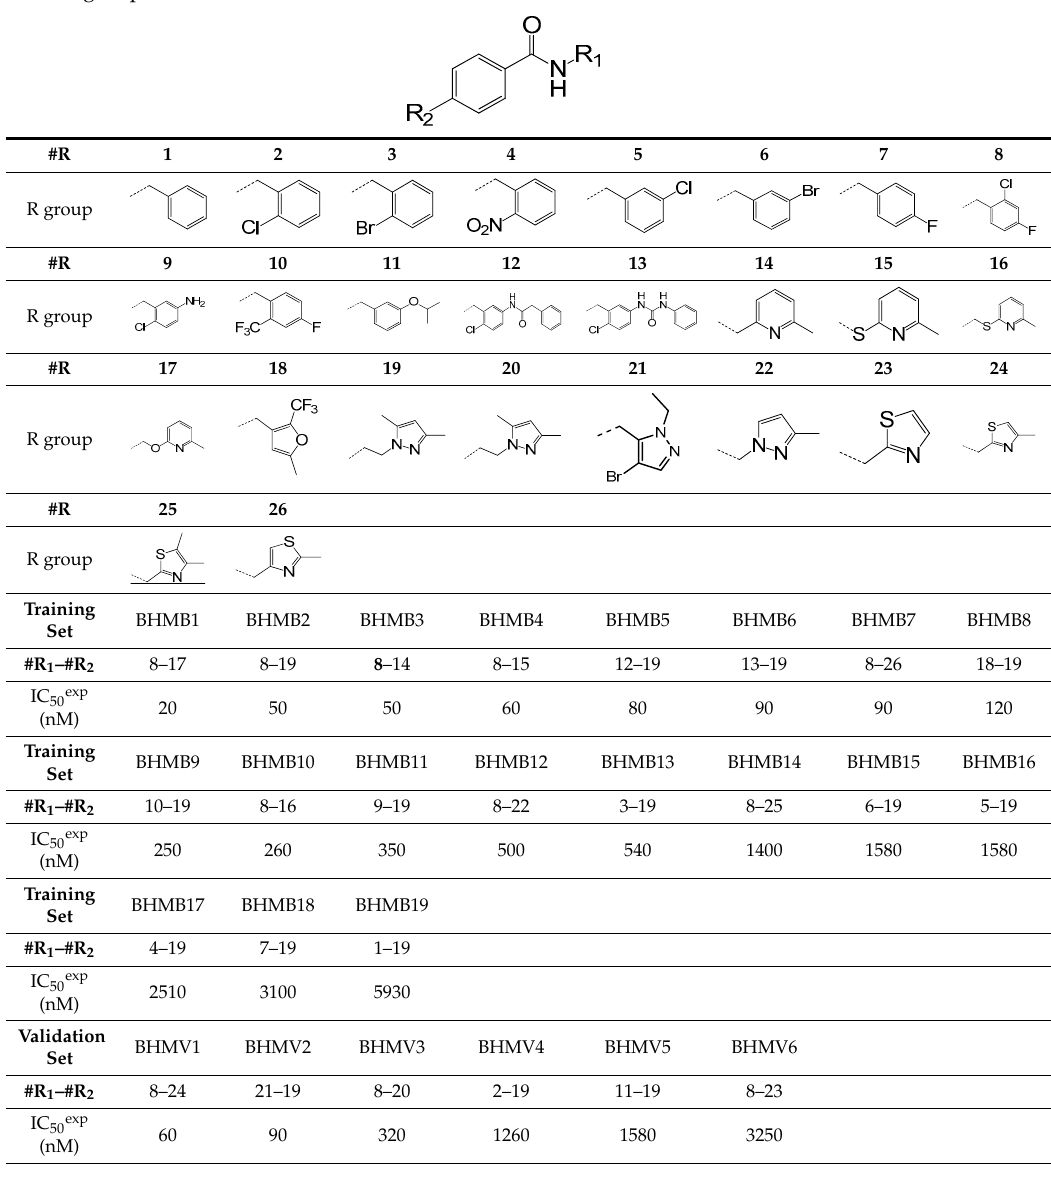
Table 1. Set (BHBM1-19) and validation set (BHBV1-6) of InhA inhibitors [23] used in the preparation of QSAR models of inhibitor binding. The R 1 and R 2 groups are numbered in the first part of the Table as #R ≡ group index.